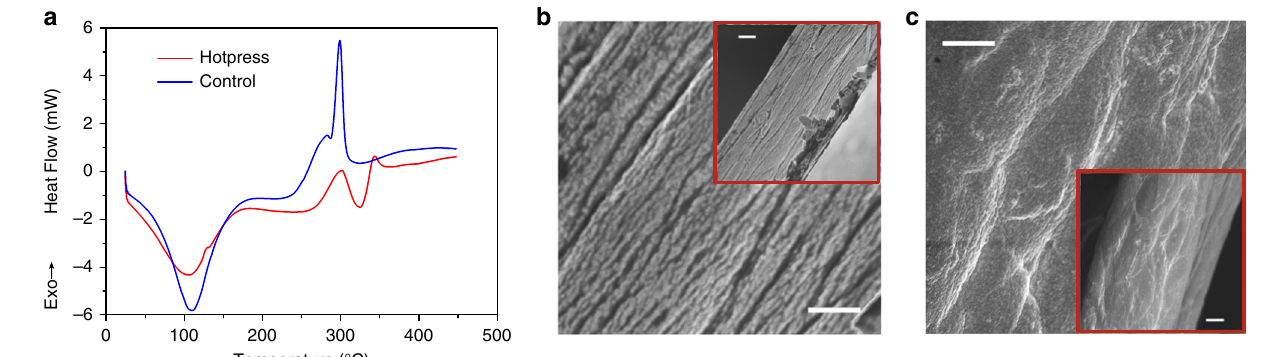
Fig. 4 The effect of treatment on cellulose crystallinity and morphology. a DSC thermograms of hot-press ( red line ) and control ( blue line ) fi lms. The melting and oxidation temperatures are 302.9 and 345.5 °C for hot-press fi lm; 281.3 and 299.0 °C for air-dried fi lm. The endothermic peak in this range corresponds to melting process of cellulose 42 . The difference of oxidation (decomposition) temperature of the two fi lms has been veri fi ed by using TGA (Supplementary Fig. 5). b , c SEM cross-section images of b hot-pressed and c air-dried cellulose fi lms. The magni fi cation is ×15,000 for detailed view (scale bar, 1 µ m) and ×5,000 for full view (inset, scale bar, 2